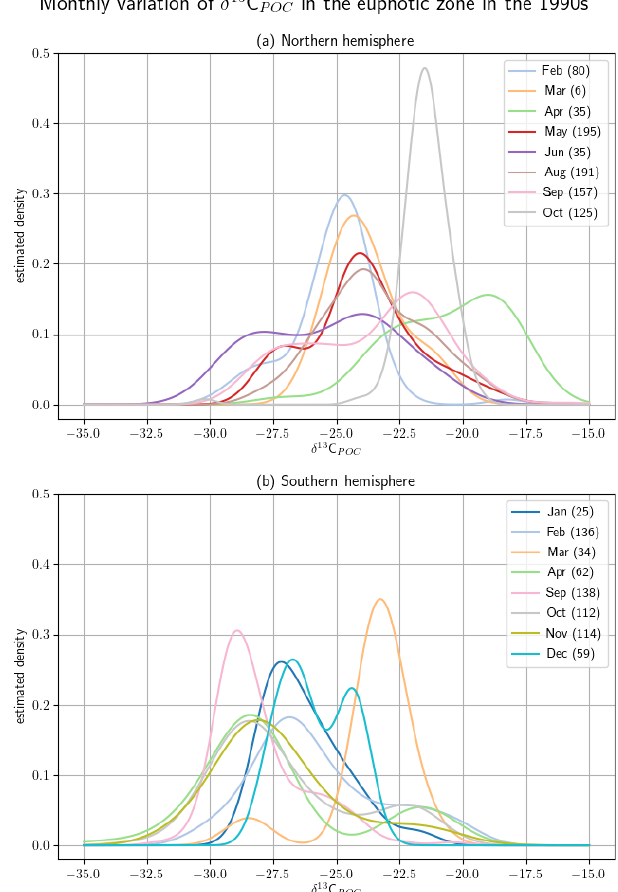
Figure 9. Monthly variations are split up by hemisphere with the Northern Hemisphere in (a) and Southern Hemisphere in (b) . Due to their having the best data coverage, the analyses are carried out within the 1990s and in the uppermost 130m. The δ 13 C POC val- ues are split up by sample month, and for every month with enough available data points (here more than three) a Gaussian KDE ap- proximates their density. The number of used data points is given in each KDE label. For each hemisphere the densities are drawn all together; each month is indicated by an individual